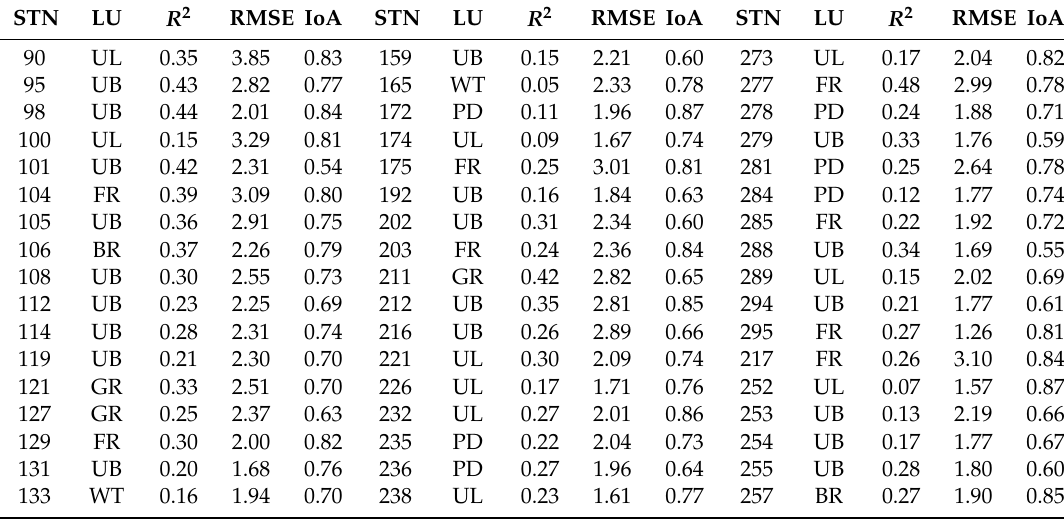
Table A2. The T MX prediction model results of 79 meteorological stations in the heat wave period (2018.07.11.–2018.08.16.). The unit of RMSE is degrees